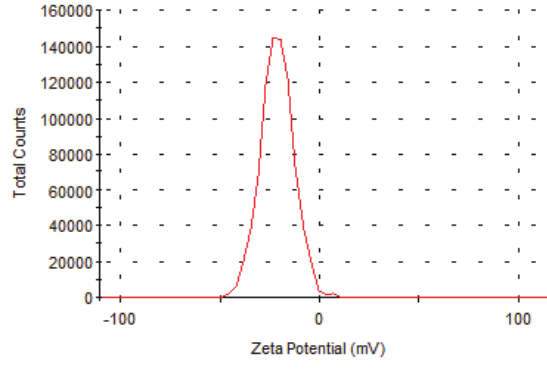
Figure 8: Zeta potential stabilization pattern analysis of synthesized FeNP using ASP . A